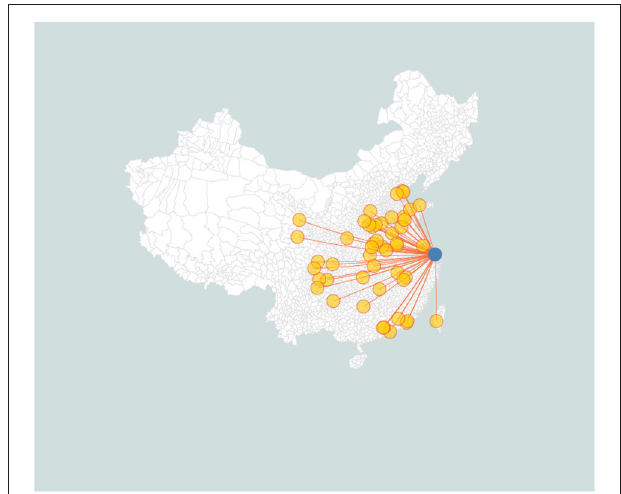
FIGURE 1 | Locations of the dialects of SC-OD bi-dialectal (yellow-filled circles) and Shanghai (the blue solid circle) on a map of China. The empty areas in the map are either deserts with little population or where non-Chinese languages are primarily spoken besides